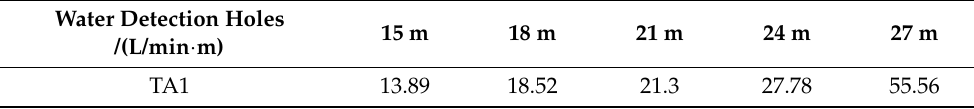
Table 14. PDK365+335 to +308 circular segment (0.8 MPA).